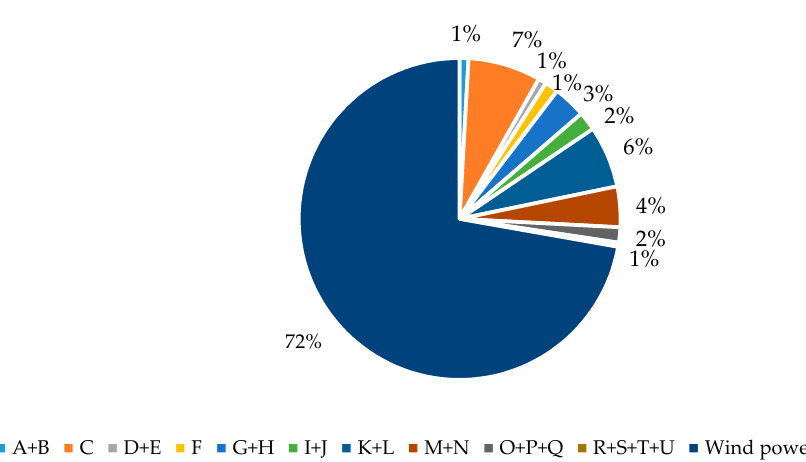
Figure 4. Investments channel during deployment of plants, the structure of total employment effects per sectors.